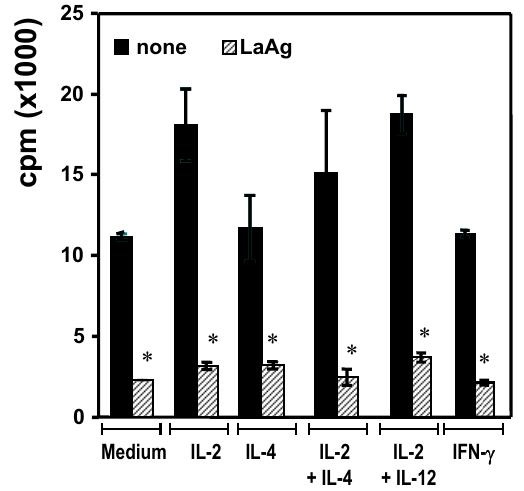
Fig. 3 – Inhibitory effect of LaAg in the presence of exogenous cytokines. Draining lymph node cells from 7-day-infected mice wereculturedfor2hoursinthepresenceofIL-2(100U/ml), IL-4 (100 U/ml), IL-12 (5 ng/ml) and/or IFN- γ alone or in combina- tion as indicated. 40 µ g/ml LaAg was then added and cells were cultured at 37 ◦ C/4% CO 2 for a further 46 hours. The prolifer- ative response was expressed in cpm, as described in Materials and Methods. Mean ± SD (n=3). Asterisks indicate p ≤ 0 ,